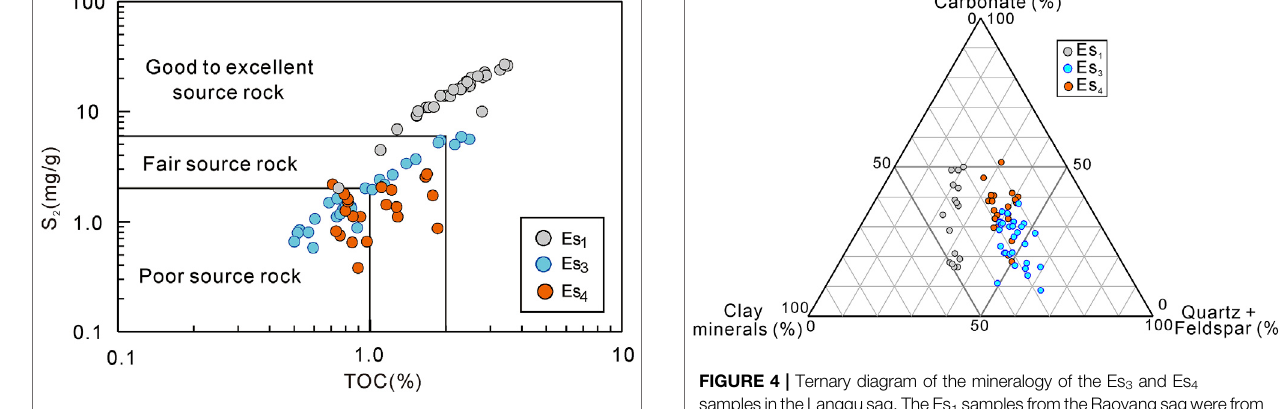
FIGURE 3 | Crossplot of total organic carbon (TOC) contents vs. Rock- Eval S 2 values for Es rock samples from the Langgu sag, Jizhong subbasin. The classi fi cations refer to Hao et al. (2009b). The Es 1 source rock samples from the Raoyang sag (Yin et al., 2018) were plotted for comparison of hydrocarbon-generating potentials.